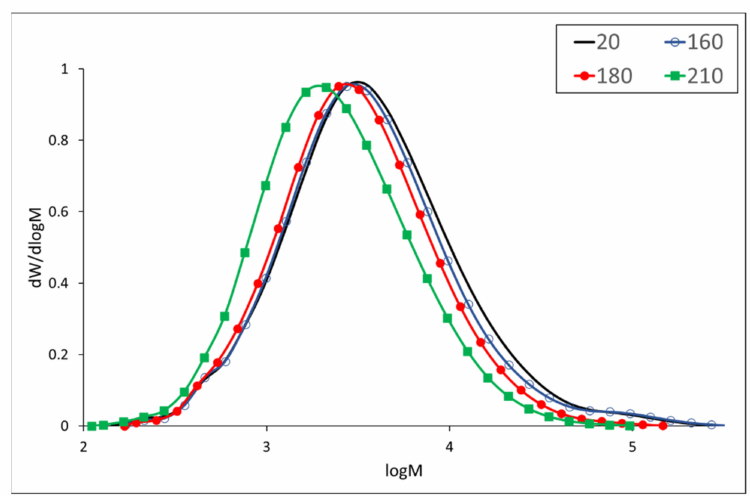
Figure 1. Molecular weight distribution of meranti wood